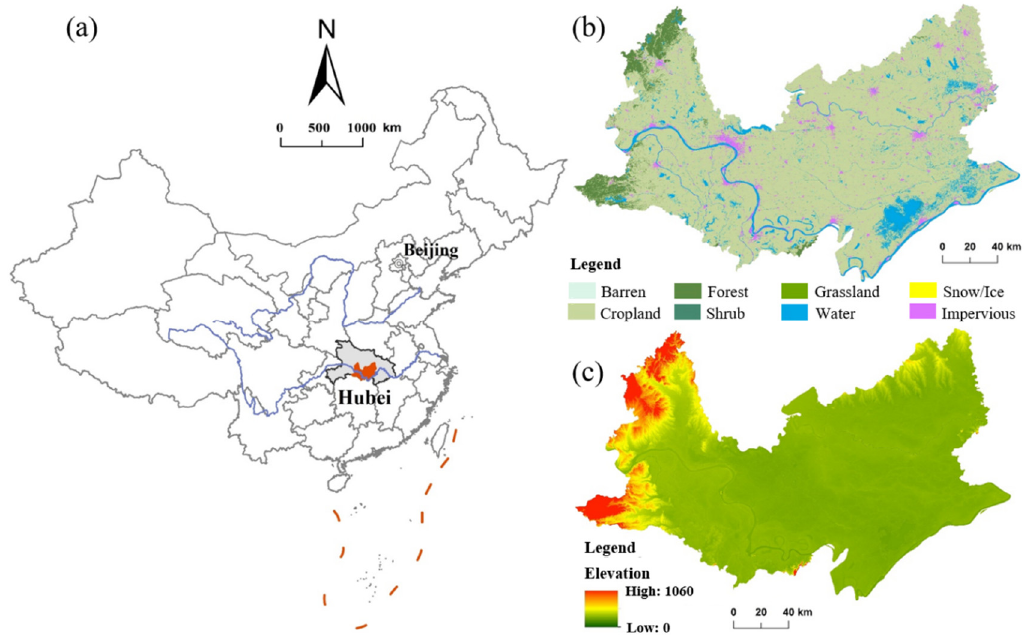
Figure 1. Overview of the study area showing ( a ) the geographical location of the study area in China, ( b ) the different types of land use in the study area, and ( c ) the elevation of the study